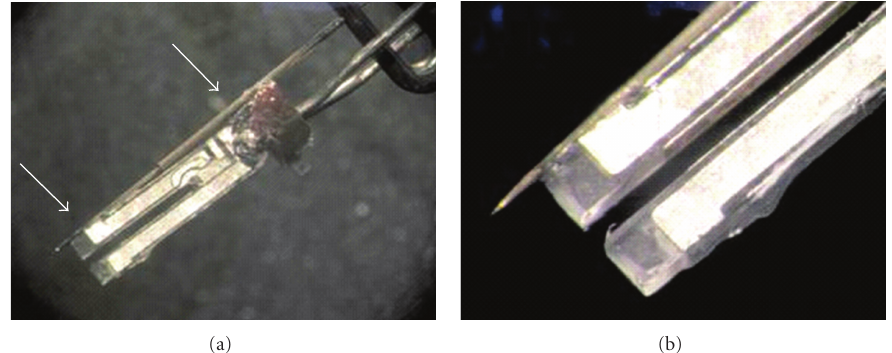
Figure 3: Optical images of the tips glued on a quartz tuning fork. (a) Points of glue are indicated by arrows. (b) Zoom of the quartz fork with the tip.